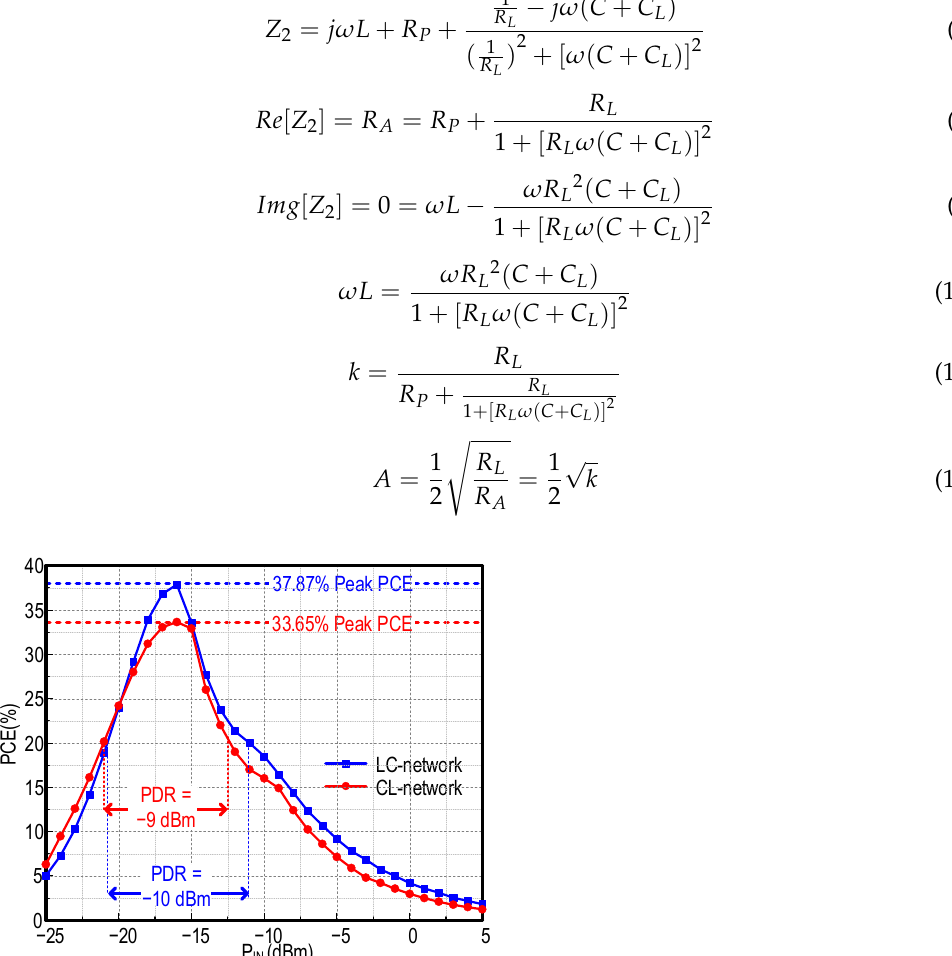
R P C P Parallel model Figure 7. Rectifier’s equivalent impedance model interchangeable from series to parallel. There are four configurations of a conventional L-network [18], as shown in Figure 8. It is categorized into two categories, with either the real impedance of the source, R S being larger or smaller than the rectifier’s equivalent series real impedance, R L . Each cat- egory has a high or low pass to block or pass the DC signal. A shunt capacitor and series